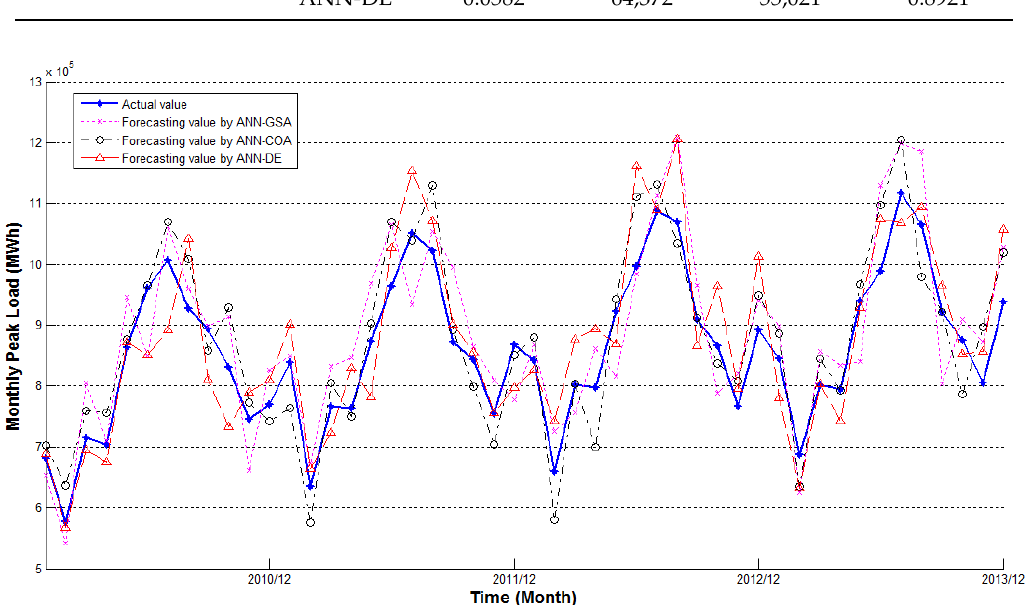
Figure 8. Root mean squared error (RMSE) values in 2000 iterations. Table 3. Performance statistics of the Autoregressive Integrated Moving Average (ARIMA) and Multiple Linear Regression (MLR). Method